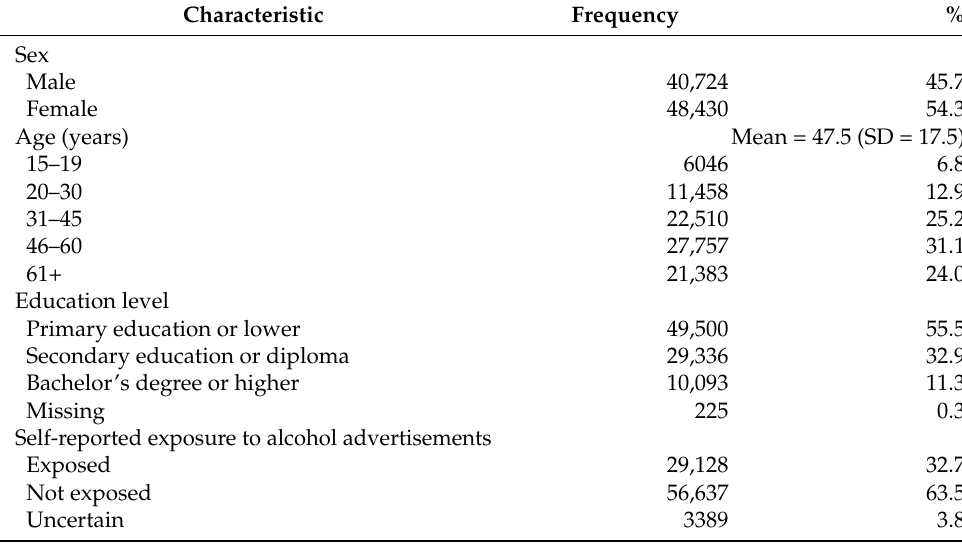
Table 1. Characteristics of participants in the